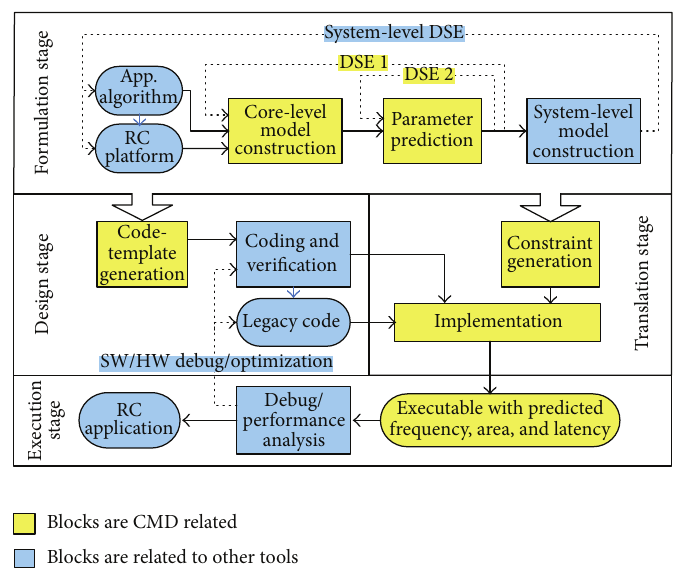
Figure 2: CMD methodology and FDTE model (dotted lines indicate iterative processes).